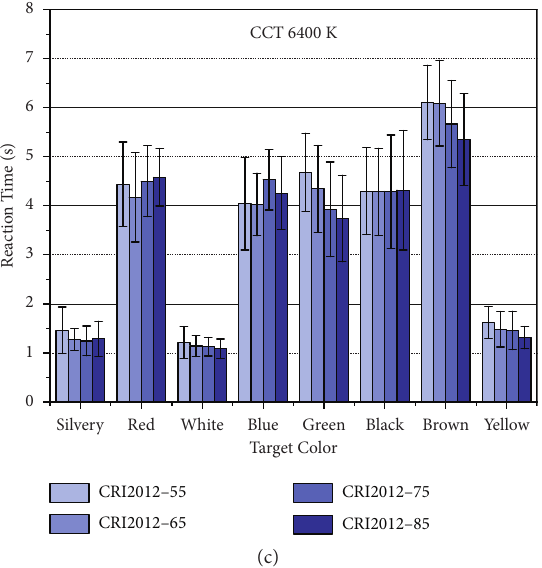
Figure 14: The reaction time of all observers under different CRI2012s and CCTs.